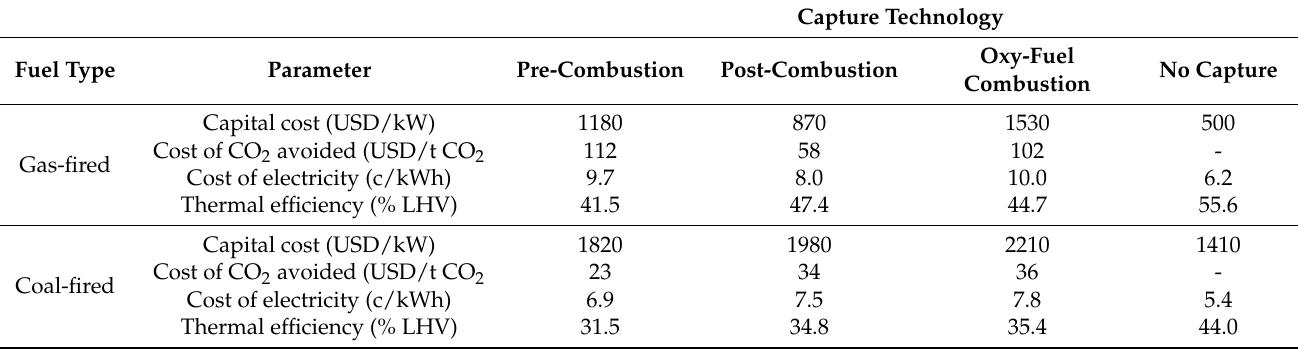
Table 2. Comparison of the costs of various capture methods [35,37]. Costs exclude storage and shipping costs, but include CO 2 compression to 110